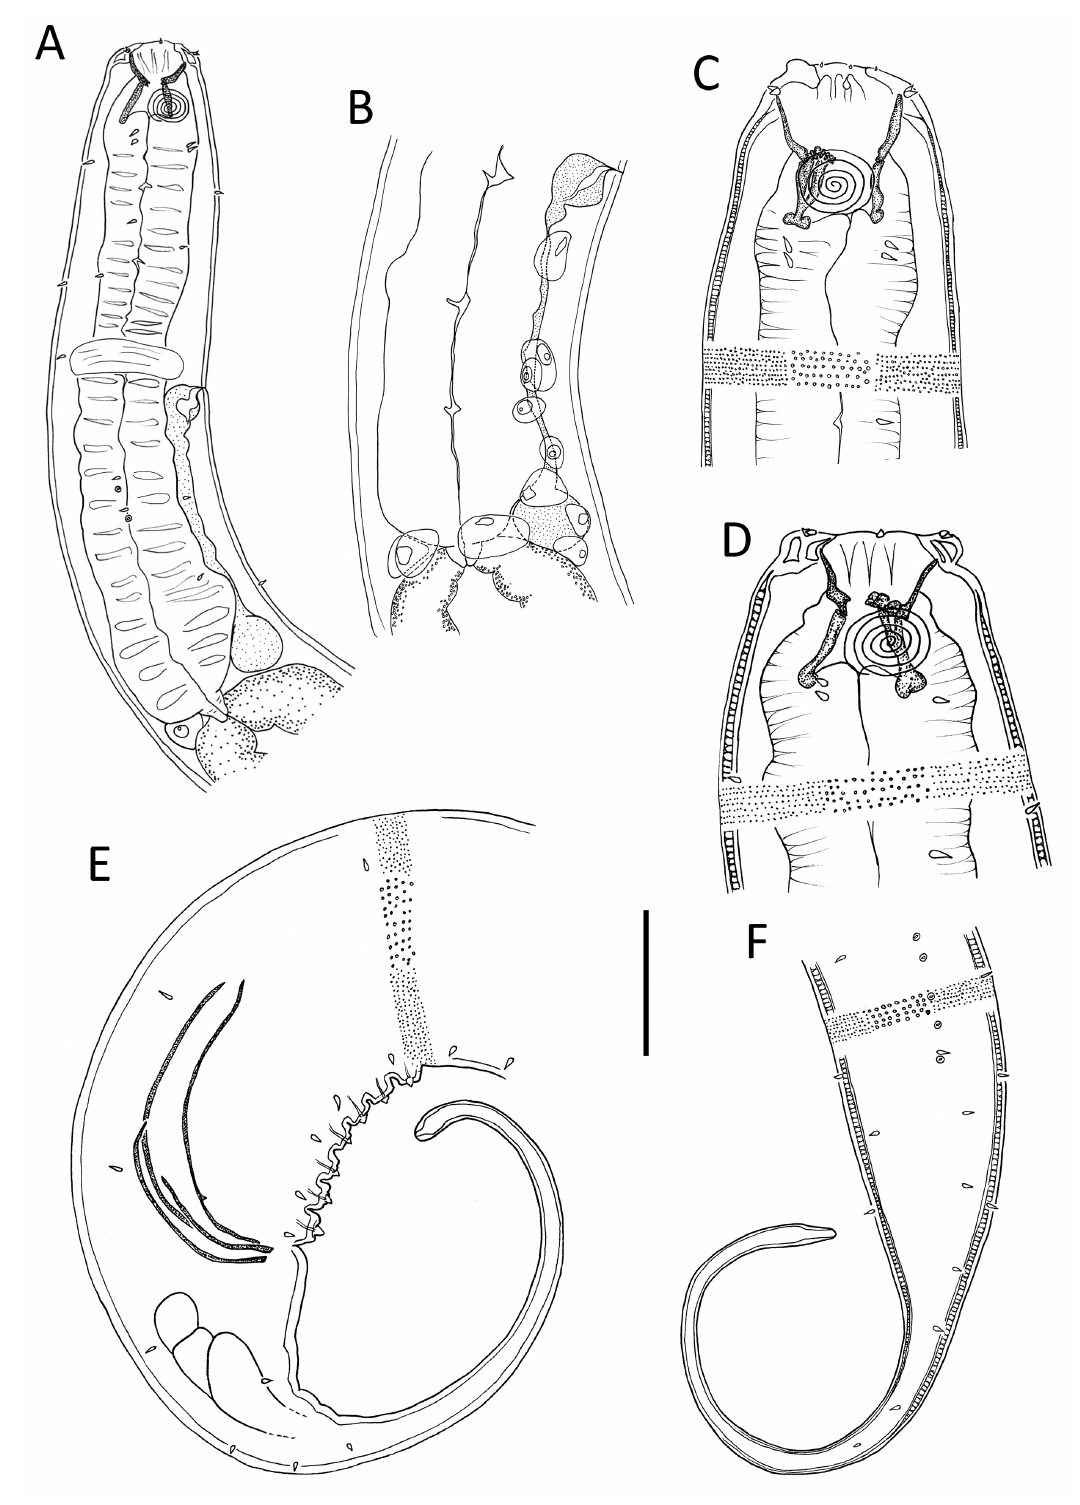
Fig. 1. Halichoanolaimus ovalis Ditlevsen, 1921 A . Male anterior body region. B . Posterior male pharyngeal region and anterior intestinal region showing location of pseudocoelomocytes. C . Female cephalic region. D . Male cephalic region. E . Male posterior body region. F . Female posterior body region. Scale bar: A = 50 µm; B = 37 µm; C, E = 27 µm; D = 25 µm; F = 35